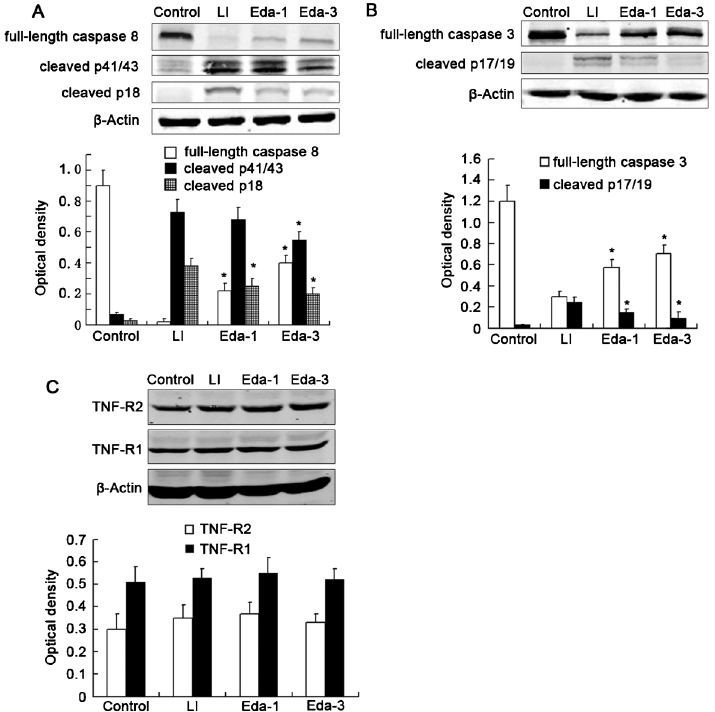
Figure 4. Western blot assay of caspase-3, caspase-8 and TNF-R. LI group: liver injury induced by D-galactosamine and lipopolysac- charide (GalN/LPS); Eda-1 and Eda-3 groups: edaravone at 1 and 3 mg/kg 30 min before and 4 h after GalN/LPS-induced liver injury. Data are